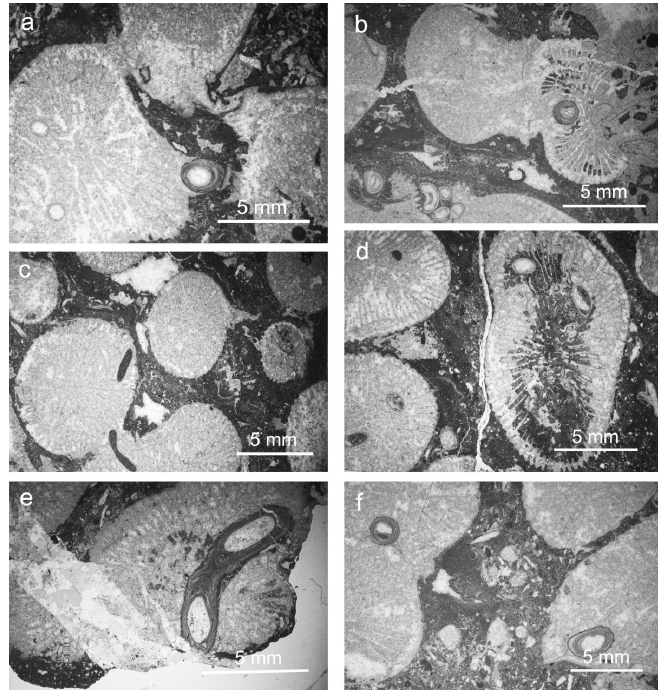
Figure 3 Figure 3. Coral–worm association in the Štramberk Limestone (Czech Republic). ( a ) Thin walled- tubes (Type 1) in the calyx and thick-walled tube (Type 2) at the edge of the corallite, transverse section. Note: wall modification induced by the worm. ( b ) Thick-walled tube in the middle of the calyx and serpulid tubes attached to the coral wall (note skeleton aberrations), transverse section. ( c ) Thin- walled tube in oblique section. ( d ) Thick-walled tubes in the middle of the calyx, transverse section. ( e ) Thick-walled tube with growth lamellae, oblique section. ( f ) Thick-walled tubes in the transverse section. ( a , b , d )— Calamophylliopsis flabellum , ( c )— Calamophylliopsis sp. ( a , b , d , f )— Calamophylliopsis sp., ( c ) —Calamophylliopsis